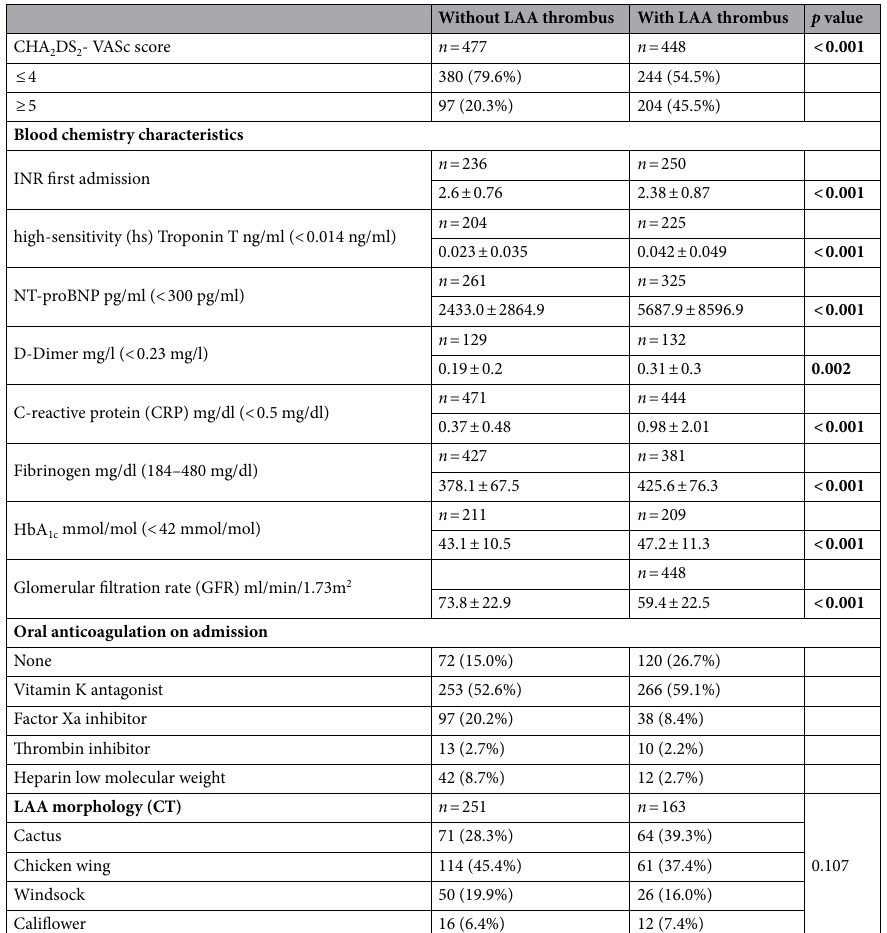
Table 1. Baseline characteristics of patients without and with LAA thrombi. Data are displayed as n (%) or mean ± SD. Actual numbers of patients differing from total number of study group are indicated separately for each parameter. Significant values are in